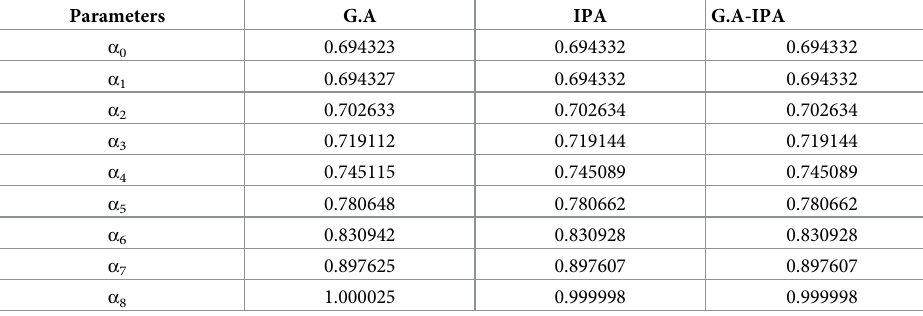
Table 13. Unknown parameters achieved by G.A, IPA and GA-IPA for δ = 2.0.